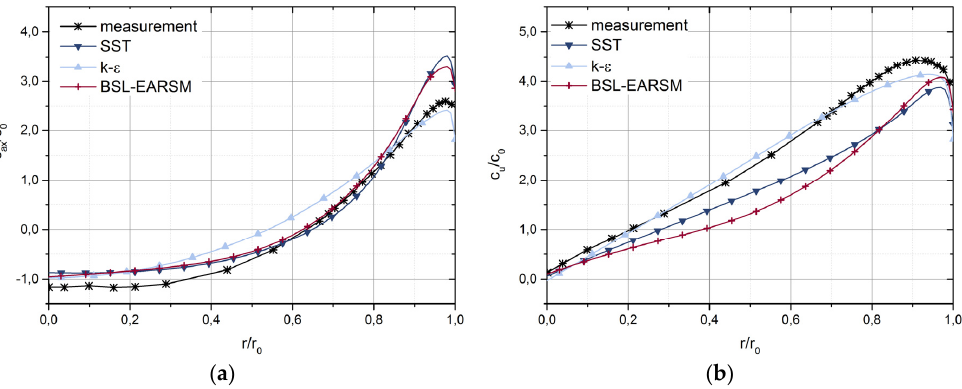
Figure 21. Comparison of axial ( c ax ) ( a ) and tangential ( c u ) ( b ) velocity profiles at the lower measurement section (L2) with the experimental velocity profiles at part load [10]; c 0 is the average velocity at the measurement plane.